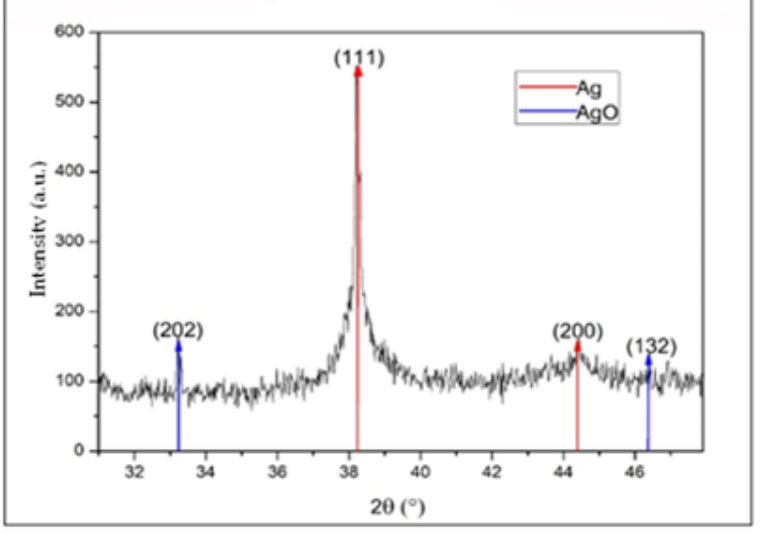
Figure 7. XRD diffractogram of silver nanoparticles between 2 θ = 30 ◦ and 48 ◦ .